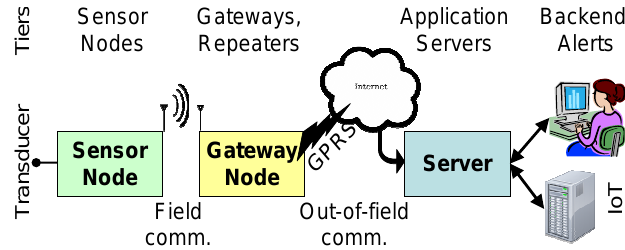
Figure 1. Typical tiered structure of WSN